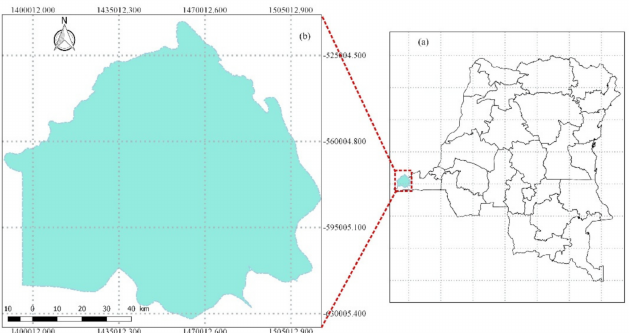
Figure 1. The study area: ( a ) The map of Mayombe forest in the Democratic Republic of Congo, ( b ) enlarged map Mayombe forest.